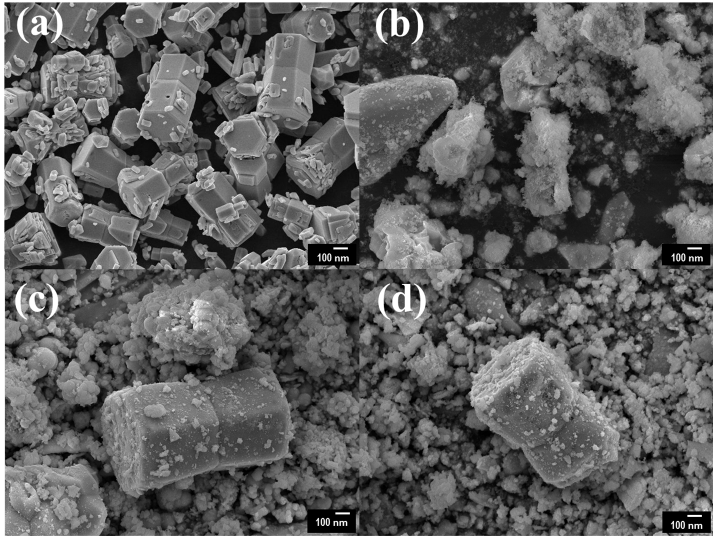
Figure 2. Field-emission scanning electron microscopy (FE-SEM) images of ( a ) pristine ZnO, ( b ) 3% Ce/ZnO, ( c ) 5% Ce/ZnO, and ( d ) 7% Ce/ZnO